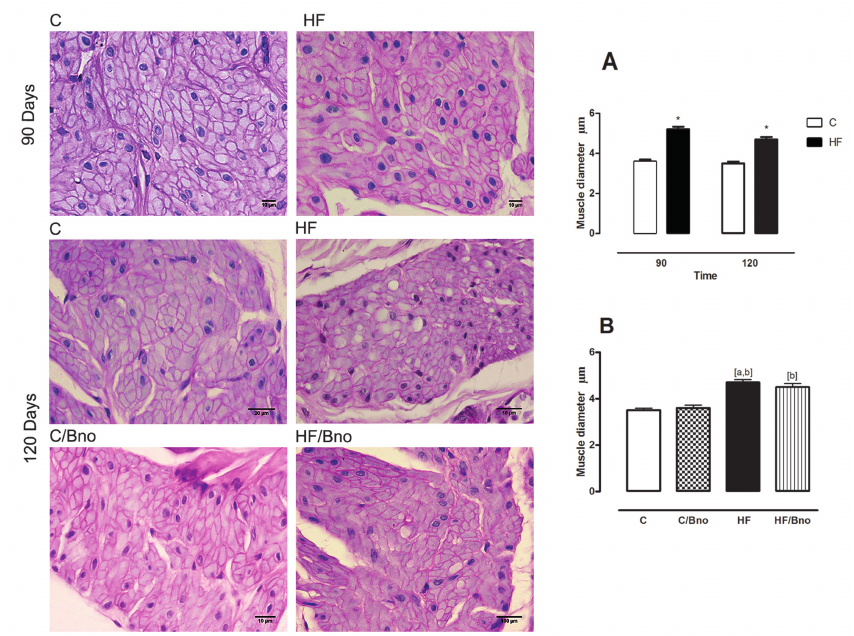
Figure 3 - Image showing the diameter of the